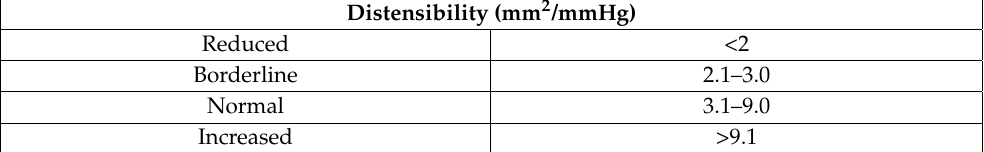
Table 1. EndoFlip™ distensibility ranges at the esophagogastric junction